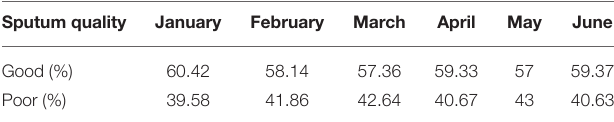
TABLE 1 | Percentage of collected sputum specimen based on its quality from January to June 2018 in Tertiary Sanglah Referral Hospital in Bali, Indonesia.